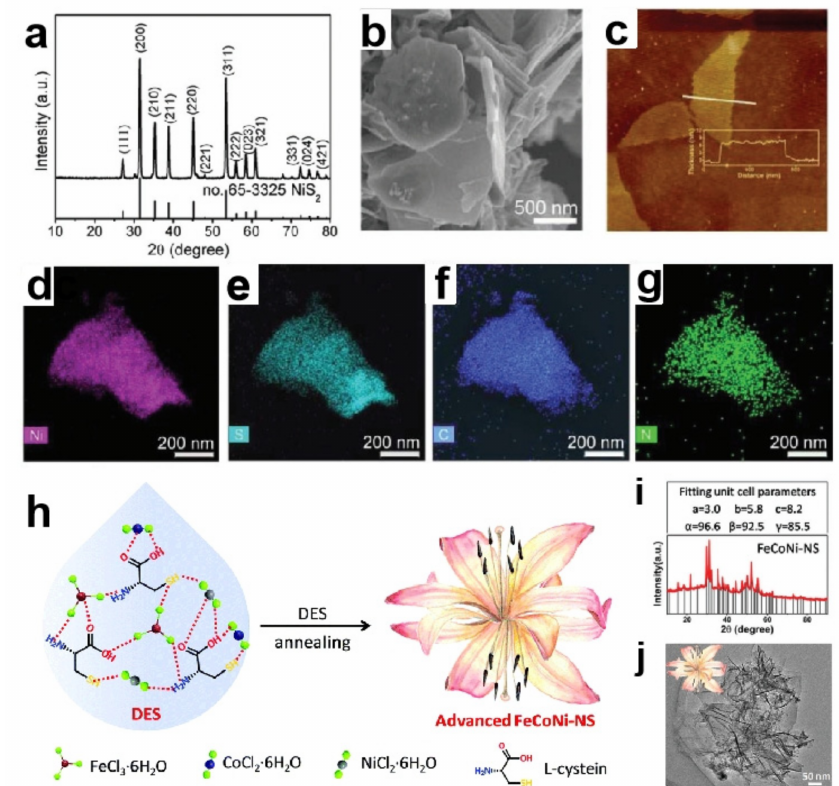
Figure 5. XRD pattern ( a ), SEM image ( b ), AFM image ( c ) and elemental mapping images ( d – g ) of the N–C/NiS 2 nanostructures. (Reprinted with permission from Ref. [79], 2020, Royal Society of Chemistry); Schematic representation of the formation of N,S-FeCoNi from the DES ( h ), XRD pattern ( i ) and TEM image ( j ) of N,S-FeCoNi (Reprinted with permission from Ref. [82], 2019, Royal Society of